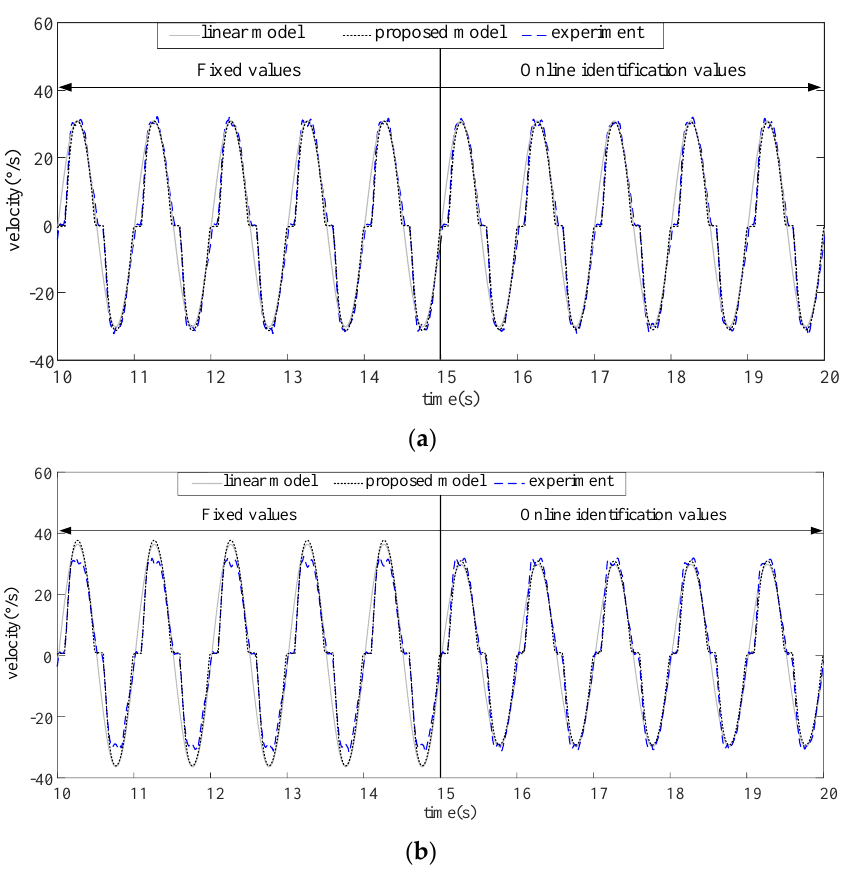
Figure 7. Dynamic model experimental verification. ( a ) Without load; ( b ) With load.